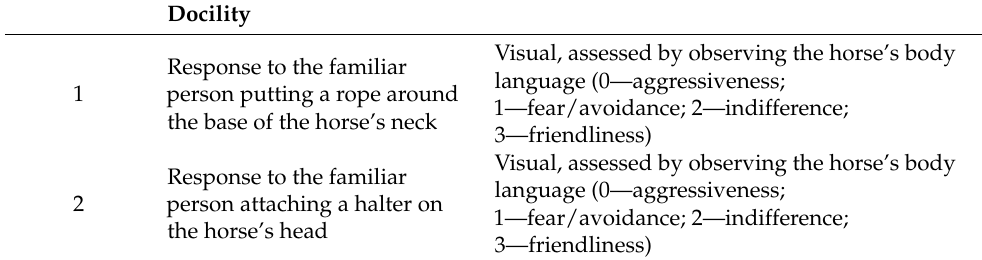
Table 2. Parameters and scoring in the docility assessment of the 32 studied